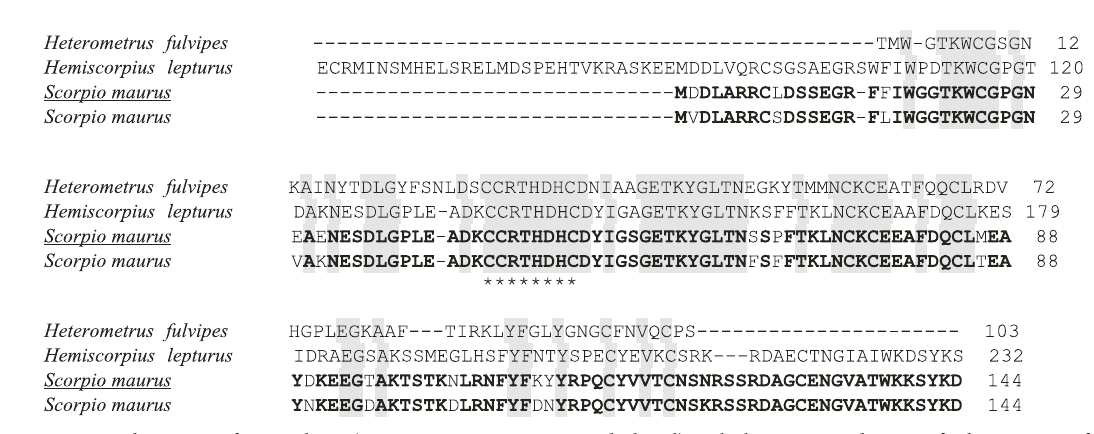
Figure 4: Sequence alignment of Maurolipin (Iranian S. maurus PLA including Tunisian S. maurus (GenBank: AVD99009.1), Heterometrus fulvipes (GenBank:Q3YAU5.1), and Hemiscorpius lepturus (GenBank: A0A1L4BJ46.1). Gaps are displayed by (-). Conserved amino acids among species are shaded in gray. Conserved amino acids between the same species of S. maurus are bolded. Conserved catalytic site is assigned by ( ∗ ). Table 1: Amino acid compounds of Maurolipin were analyzed by ProtParam online